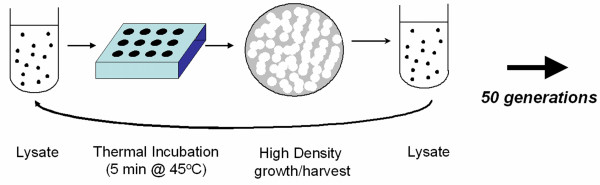
Design for an evolution experiment where bacteriophage φ6 lineages were selected to withstand damaging effects of heat shock. A virus lysate was exposed to 45°C incubation for 5 minutes, and a dilution of the surviving progeny was plated on a lawn of P. phaseolicola bacteria. Overnight plaque formation at the standard temperature of 25°C corresponded to 5 generations of virus evolution. The plaques were then harvested to remove bacteria, and the process was repeated. Duration of the experiment was 10 days, equivalent to 50 virus generations.